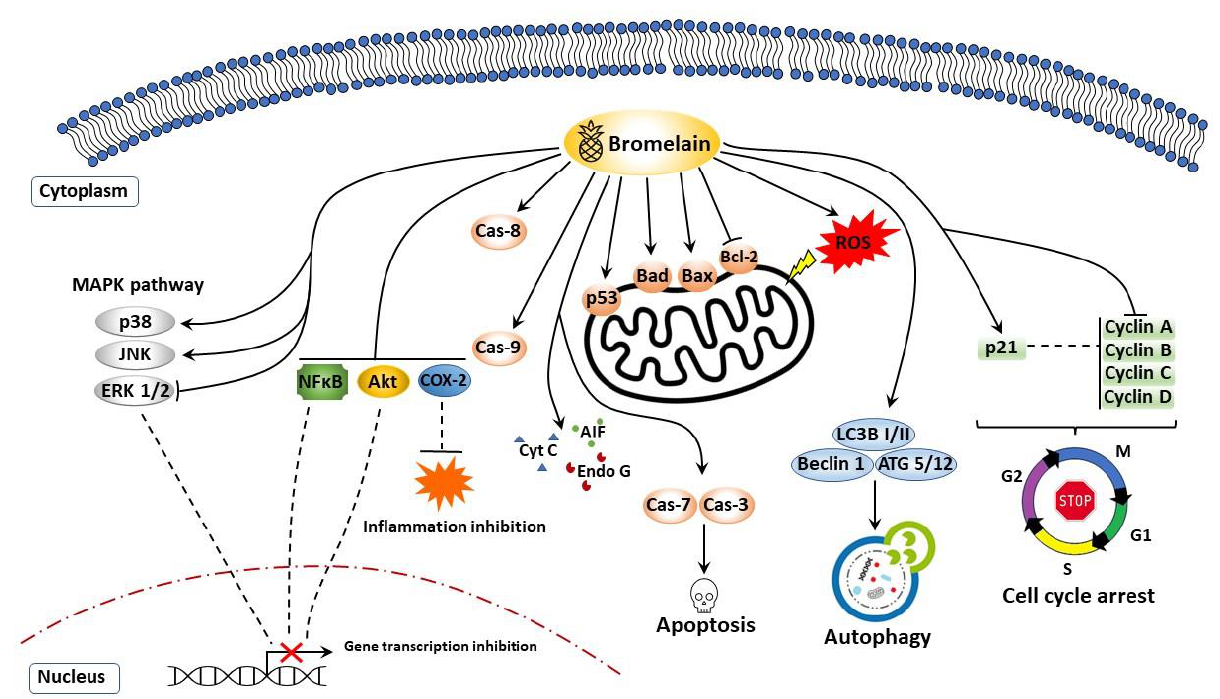
Figure 1. Possible molecular mechanisms of bromelain’s anti-tumor activity are realized at 3 levels of cellular metabolism. In vitro and in vivo studies have shown that bromelain inhibits the proliferation of cancer cells primarily by I) modulating the expression of genes crucial for cell differentiation and proliferation (MAPK signaling pathway, Akt, Cox-2, NF- κB), II) induction of cell death by apoptosis/autophagy, and III) blocking the cell cycle by inhibiting cyclins which are necessary for this process.